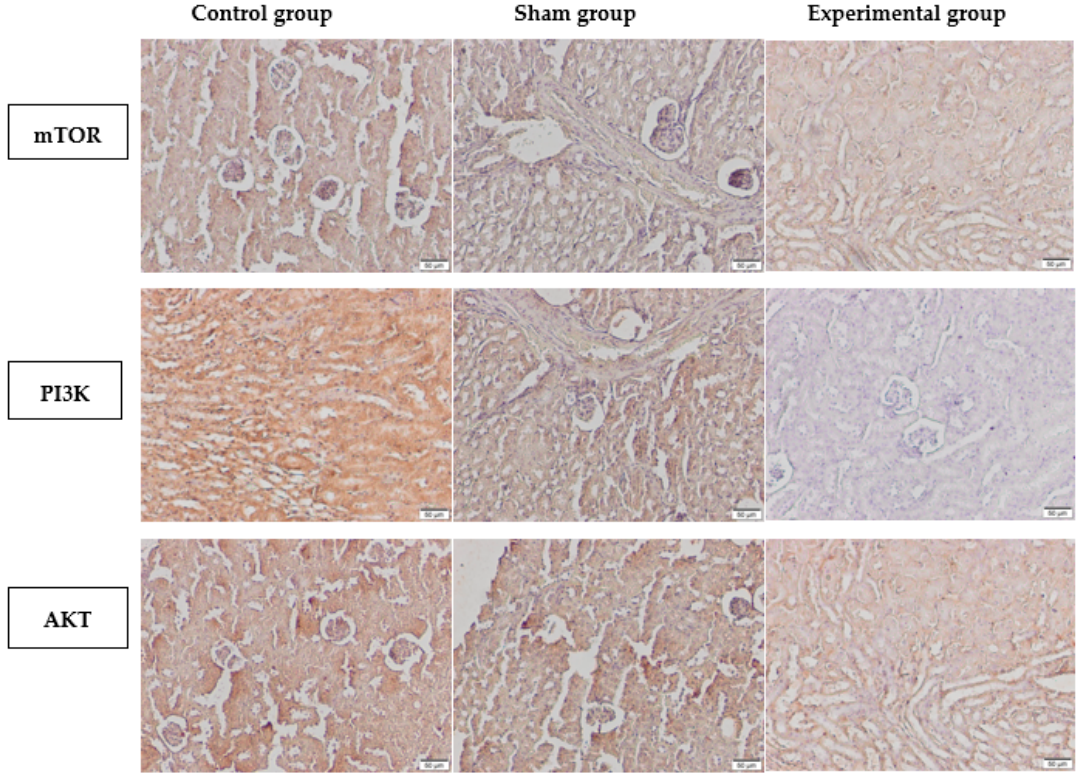
Figure 1. Distributions of PI3K, AKT and mTOR immunoreactivities in kidney samples from experimental, control and sham